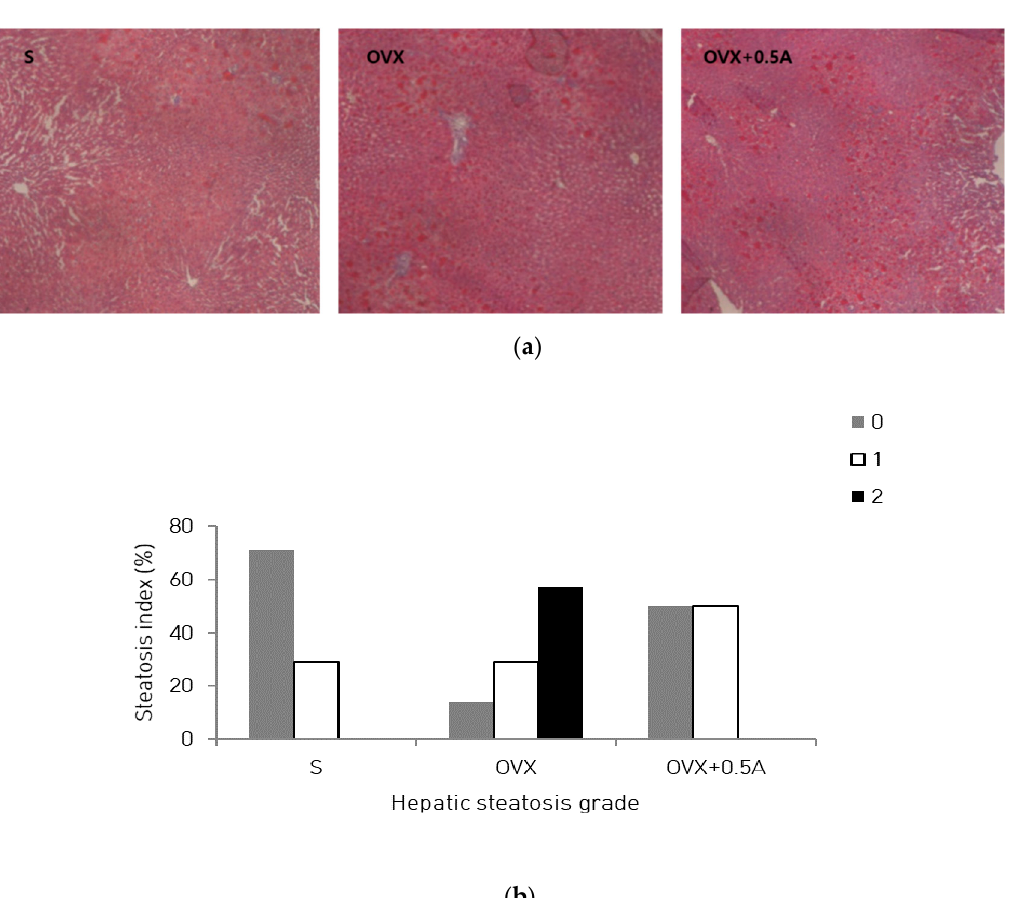
Figure 1. Effect of A. pilosa supplementation on hepatic steatosis in OVX rats fed an HFD. ( a ) Photomicrographs of hematoxylin and eosin-stained liver from representative rats in ( left ) S, ( middle ) OVX, and ( right ) OVX + 0.5A groups (×400). ( b ) Percentages of rats with each hepatic-steatosis grade (0–3scale)foreachgroup.